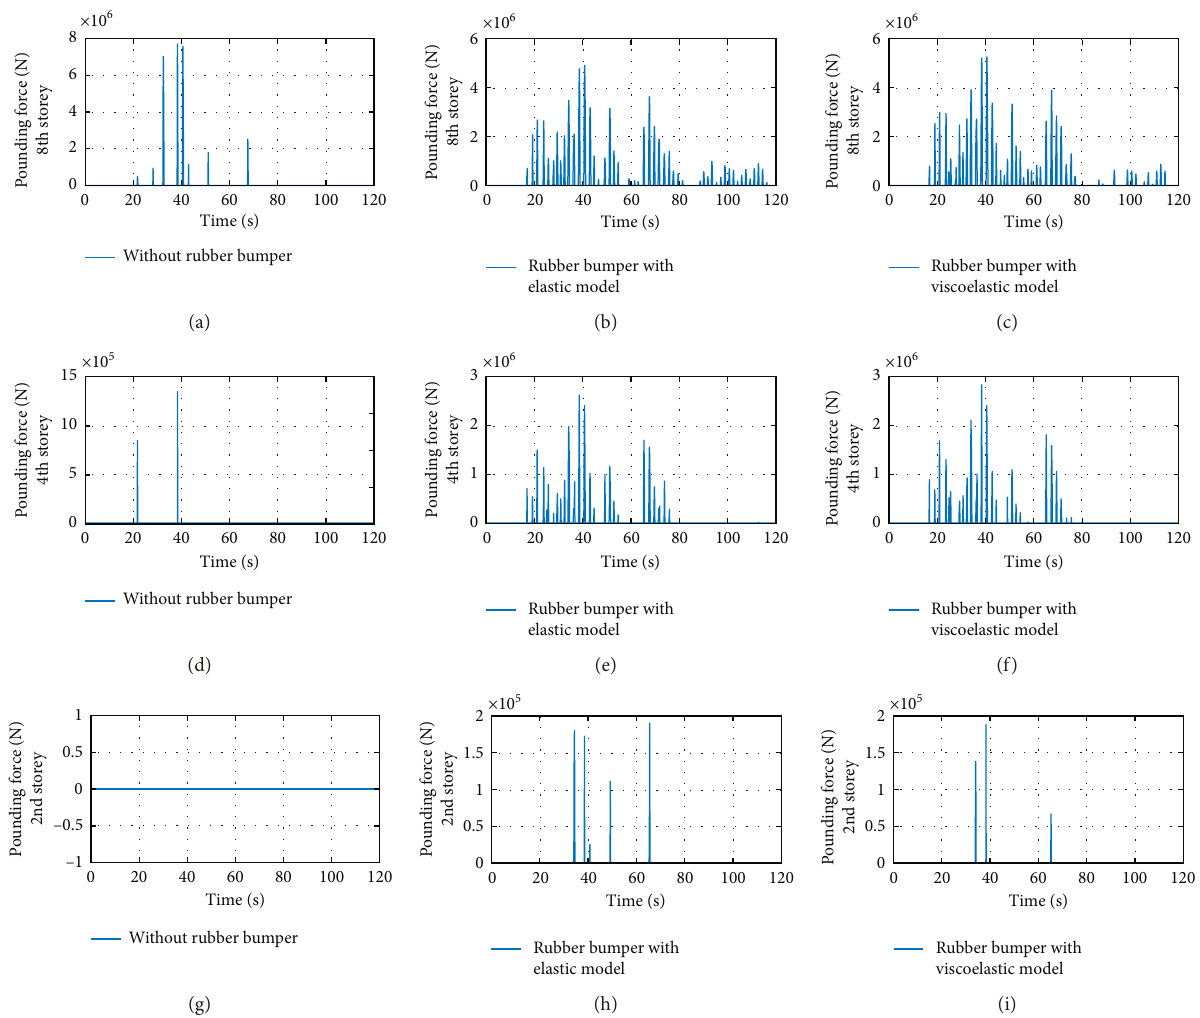
Figure 3: Pounding force time-history with three different models of collision: (a, d, g) without bumpers; (b, e, h) with bumper calculated by the elastic pounding force model; (c, f, i) with bumper calculated by the viscoelastic pounding force